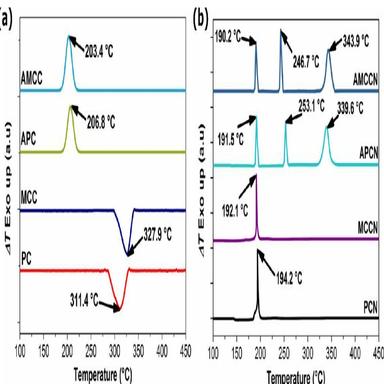
DTA curves of (a) functionalized samples and their starting precursors; (b) nitrated samples.